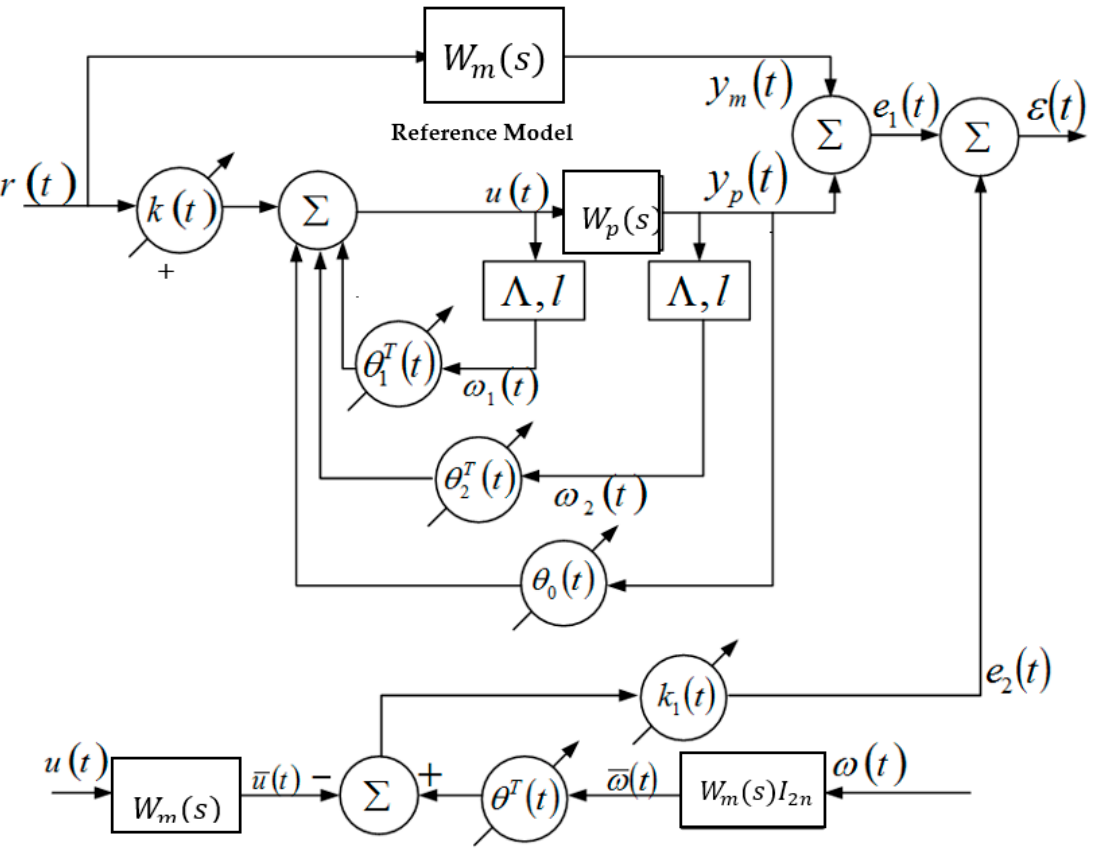
Figure 15. General structure of the DMRAC for the case when the relative degree of the plant is 𝑛 ∗ ≥ 2 .